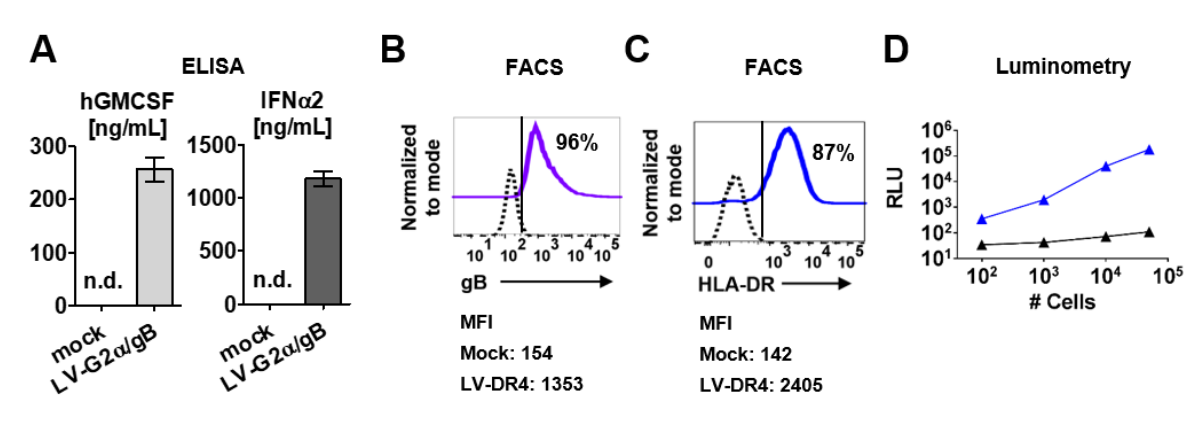
Figure 2. Detection of transgene expression in transduced cell lines. ( A ) Detection of secreted human GM-CSF and human IFN- α in cell supernatants of 293T/ Mock and 293T/ LV-G2 α /gB-transduced cells. n.d. = not detected; ( B ) 293T cells transduced with LV-G2 α /gB and analyzed by flow cytometry showed expression HCMV/gB on the cell surface. Mock (dashed black line) and LV-G2 α /gB transduced (purple line). Representative results from triplicate experiments. The mean fluorescence intensity (MFI) is indicated below; ( C ) 3T3 cells transduced with LV-DR4/fLuc and analyzed by flow cytometry showing expression of the HLA-DR dimer on the cell surface. Mock (dashed black line) and LV-DR4/fLuc transduced (blue line). Representative results from triplicate experiments. The mean fluorescence intensity (MFI) is indicated below; ( D ) analyses of luminescent signals in cell lysates obtained from 3T3 mock cells (black line) and 3T3 cells transduced with LV-DR4/fLuc (blue line).